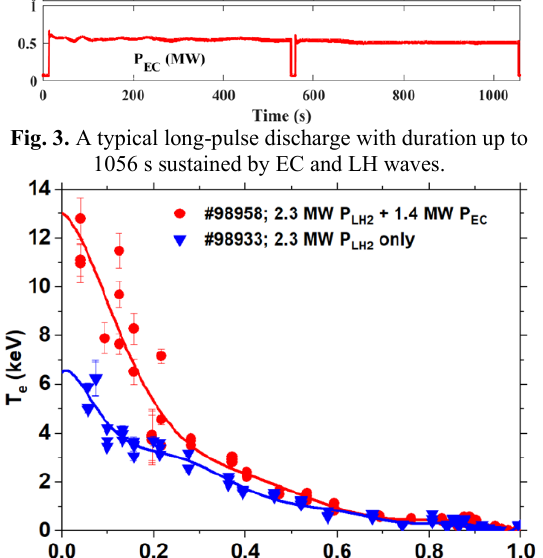
Fig. 4. Comparison of Electron temperature profiles measured by Thomson scattering with ECRH and without ECRH.